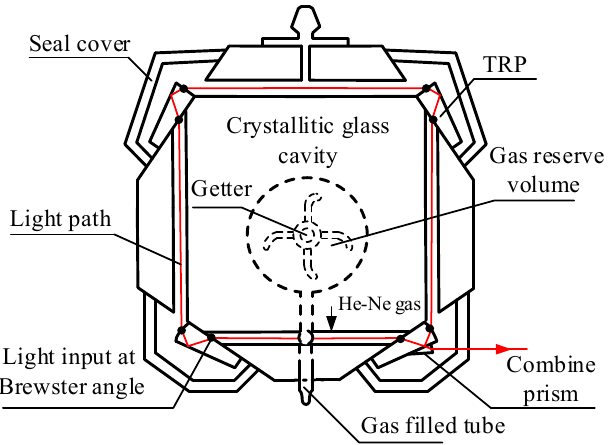
Figure 1. Schematic of the prism ring laser’s structure.